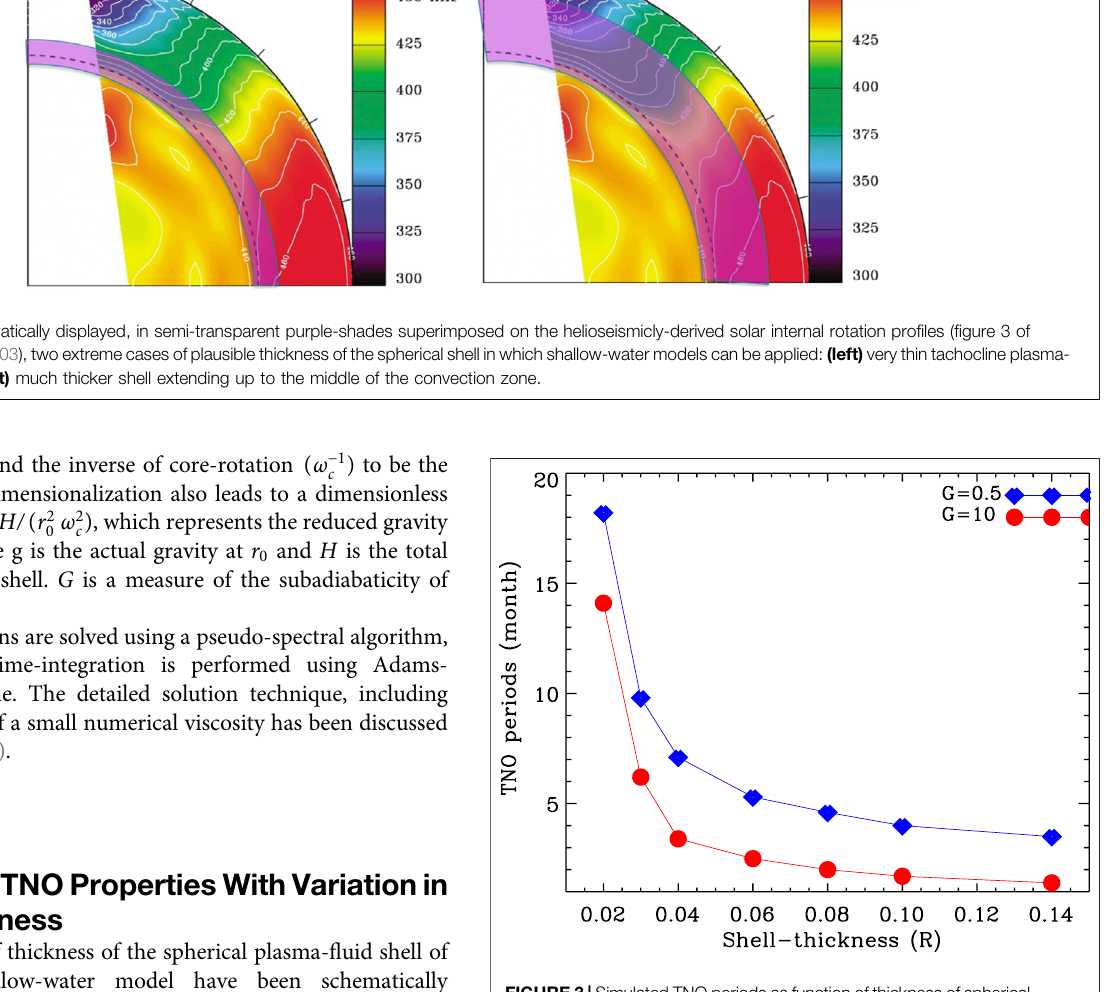
FIGURE 3 | Simulated TNO periods as function ofthickness of spherical shell of plasma- fl uid. R denotes the solar